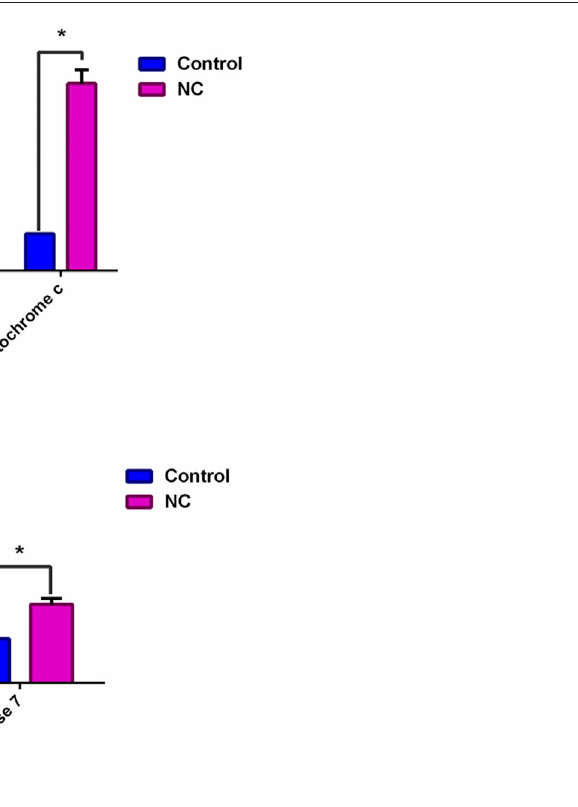
FIGURE5| EffectofNCleaves80%ethanolextractonapoptosis-relatedgeneexpressionupontreatmentwithIC 50 for72 h.Relativeexpressionfor (A) Bcl-2,Bax, and cytochrome c, and (B) caspase-9 and caspase-7 were calculated by measuring the fold change with GAPDH and β -actin as a reference gene in untreated cells, whose ratio was equal to 1. Data presented in mean ± standard deviation of triplicates of the experiment. * indicates a signi fi cant difference when p <